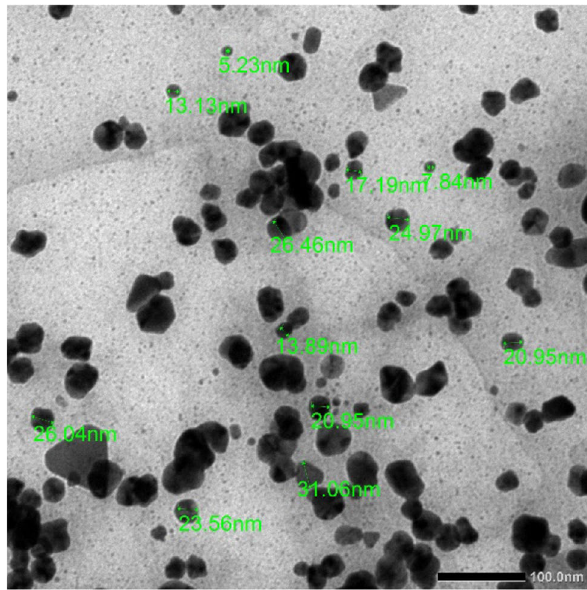
Figure 4. TEM image of AgNPs stabilized in Chitosan.